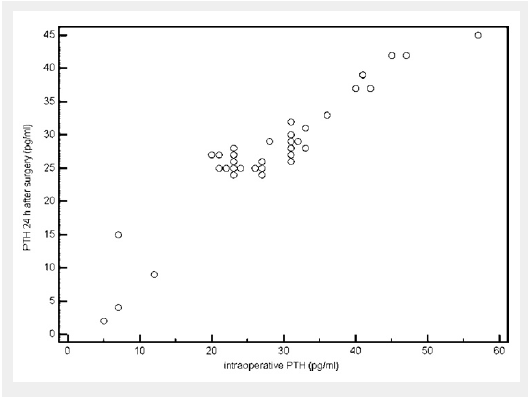
Scatter plot for correlation between intraoperative rapid PTH assay and standard PTH assay taken 24 hours after surgery. Correlation coefficient = 0.95 (P < 0.001).